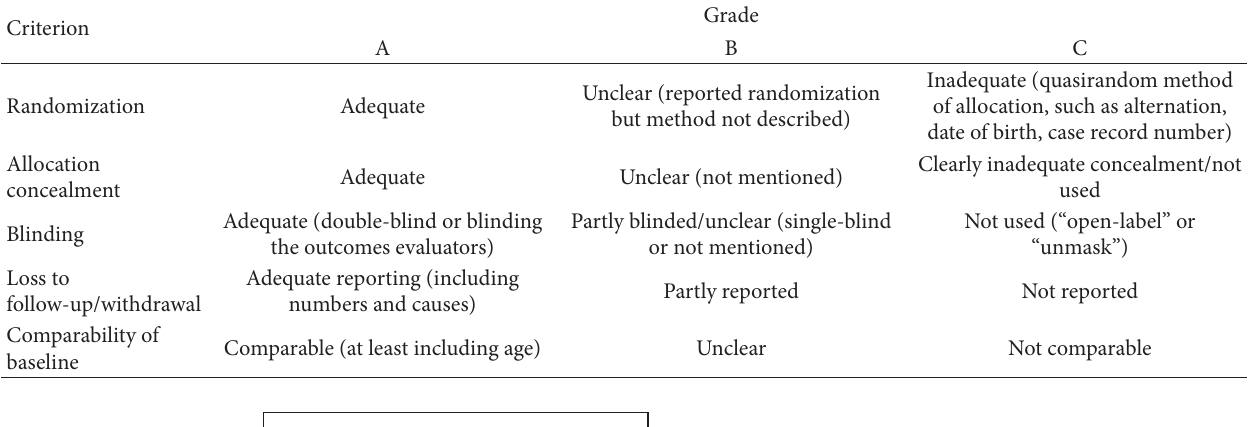
Table 1: Grade scale for quality assessment of randomized controlled trials.